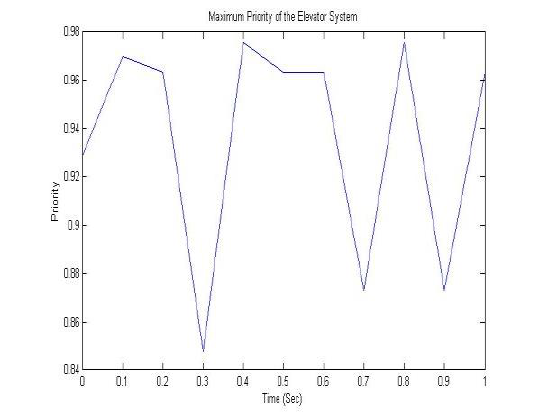
Figure 5. Maximum priority